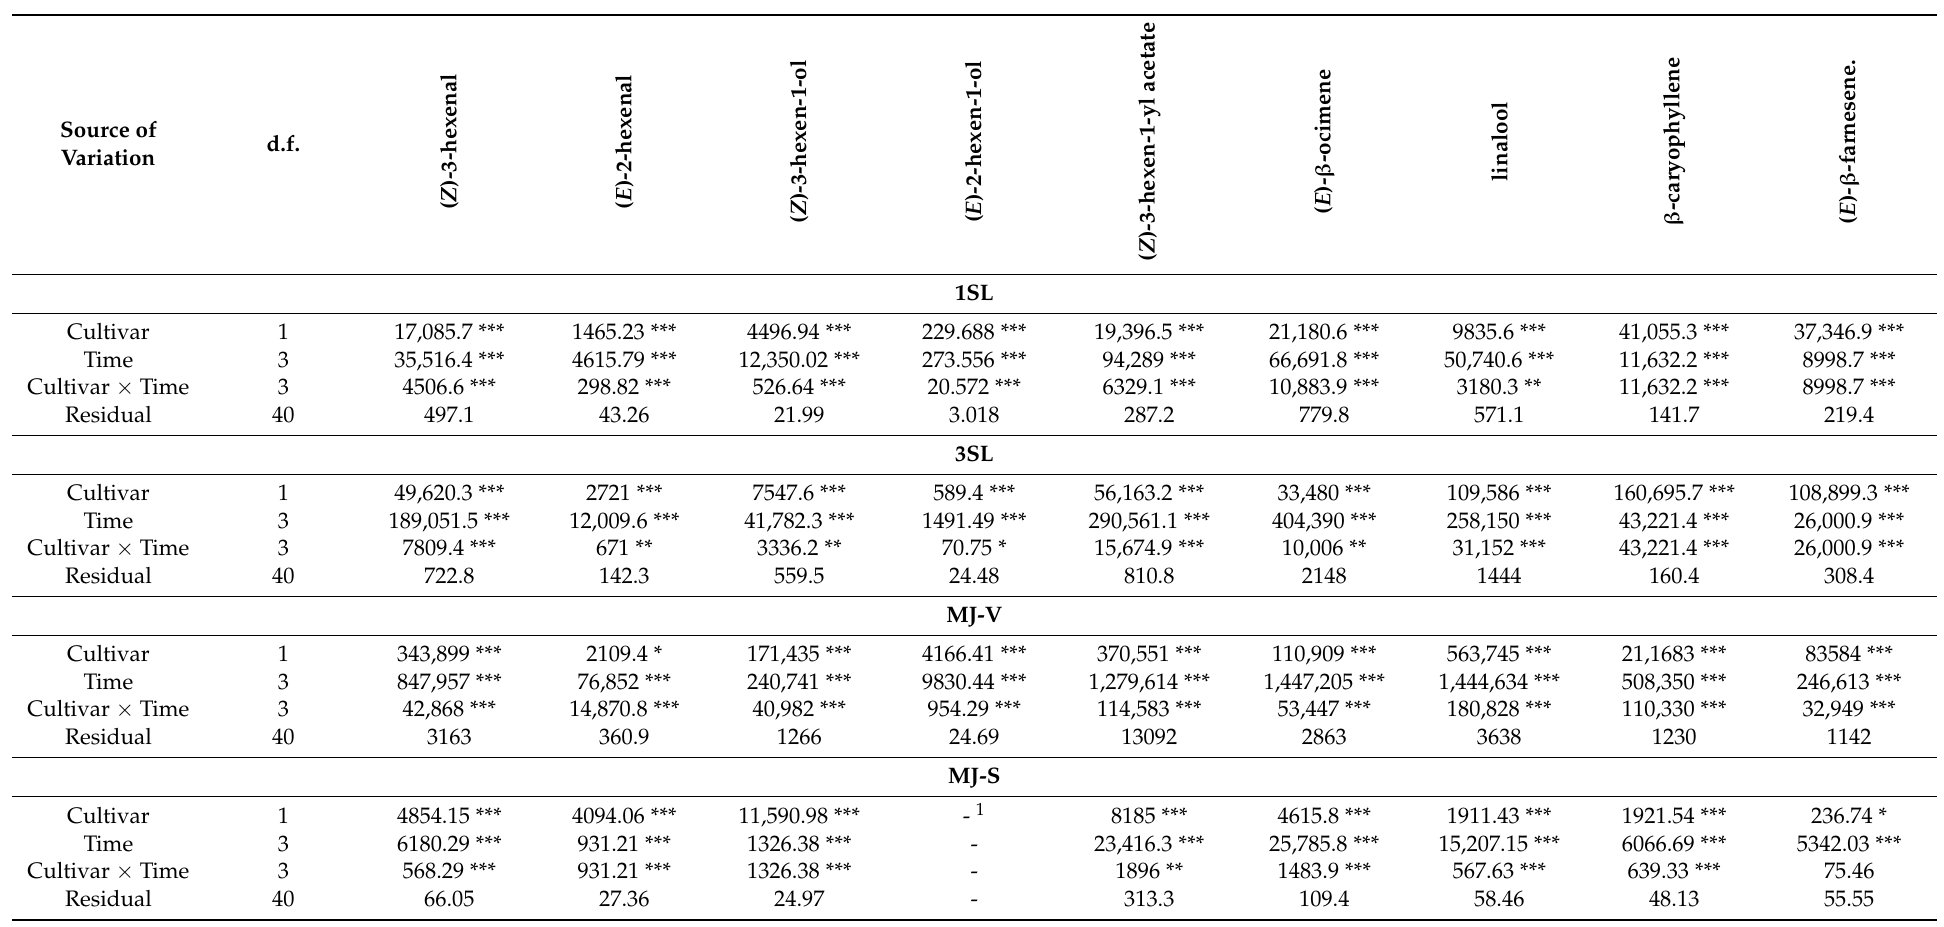
Table 3. Mean squares from two-way analysis of variance for a particular